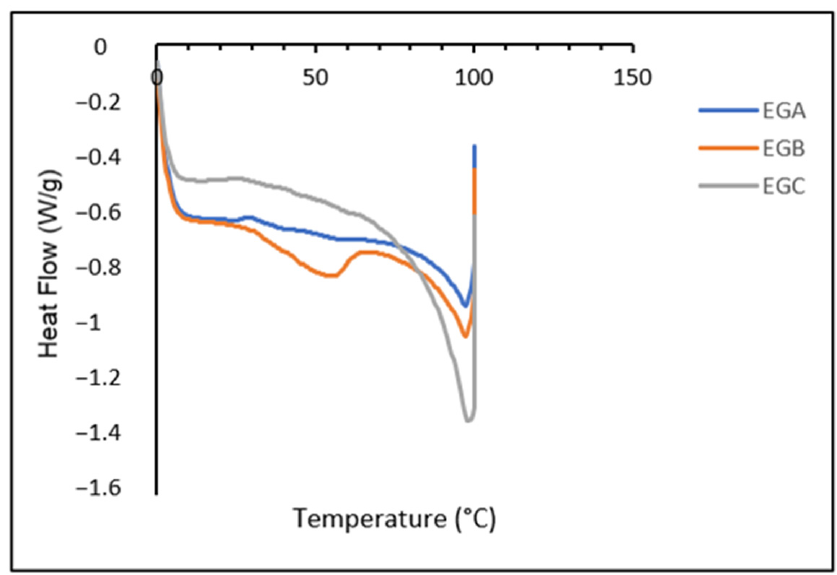
Figure 3. Differential scanning calorimetry (DSC) melting curve of EGA, EGB and EGC.